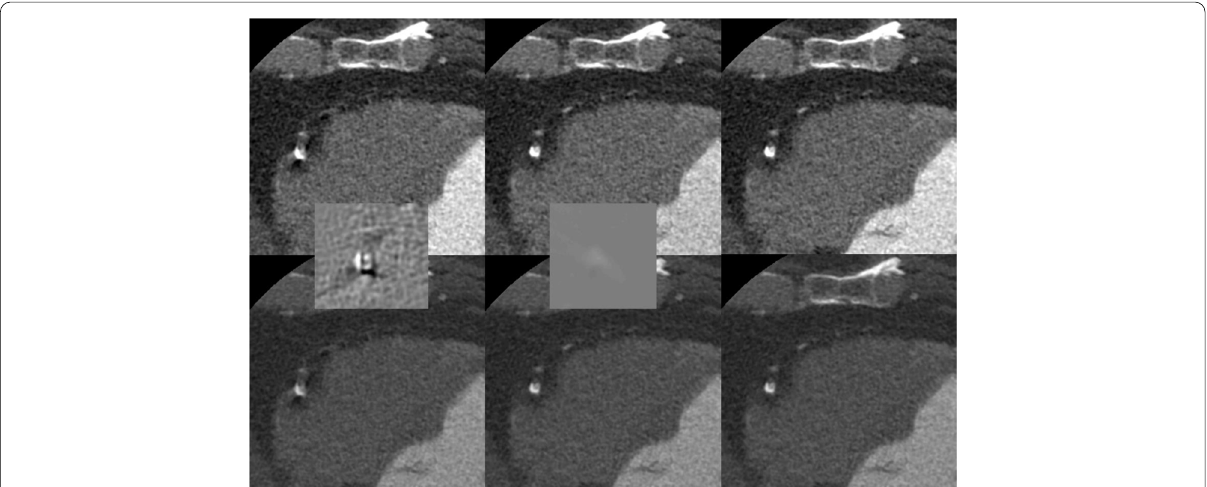
Fig. 6 CCTA exam (70 bpm, 70% R-R phase) with bright and dark streaks from calcification and effect of motion correction and beam hardening correction. Left: No motion correction, with multi-material beam hardening correction; Center: With motion correction, no multi-material beam hardening correction; Right: Fully corrected (for both motion and beam-hardening). Left inset: Difference image (with vs without motion correction); Center inset: Difference image (with vs without multi-material beam hardening correction). Top row W/L: 900/200; Bottom row W/L: 1600/400; Insets (W/L 900/0) (Credit: UCSD) =